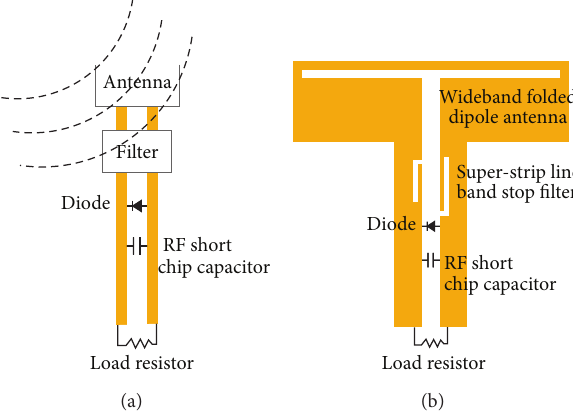
Figure 1: Aggregating relationship of 50Ohm interface rectenna system.